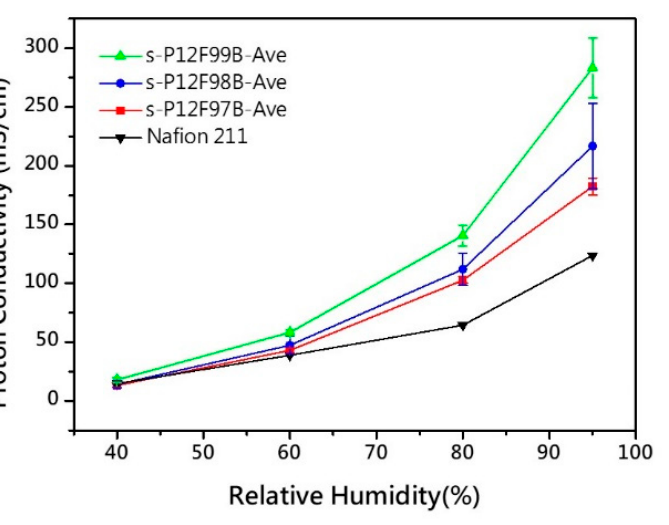
Figure 6. Proton conductivity of the s-P12FmB-Ave and Nafion 211 membranes as a function of relative humidity.